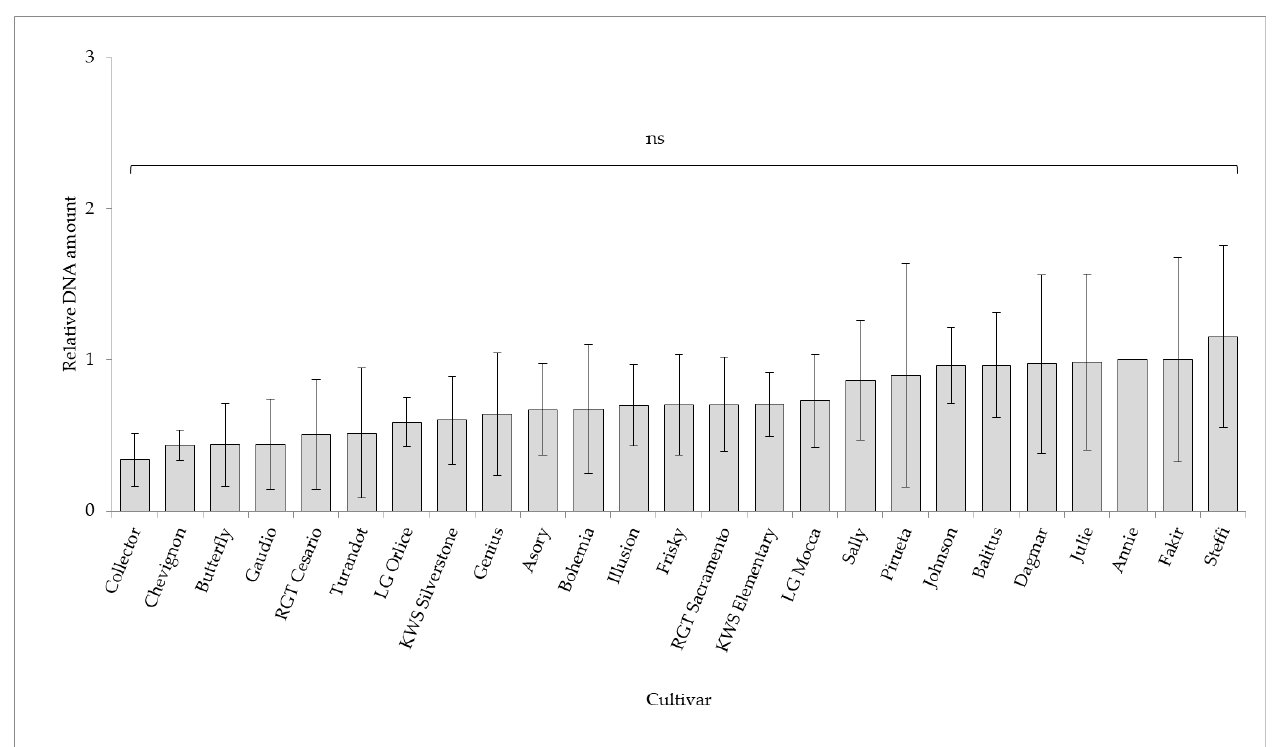
Figure 1. The qPCR assessment of Oculimacula yallundae in the winter wheat cultivars (2019 – 2021). In the ANOVA with a multiple comparison Fisher´s LSD test ( p < 0.05), homogeneous groups are marked with the same letters.